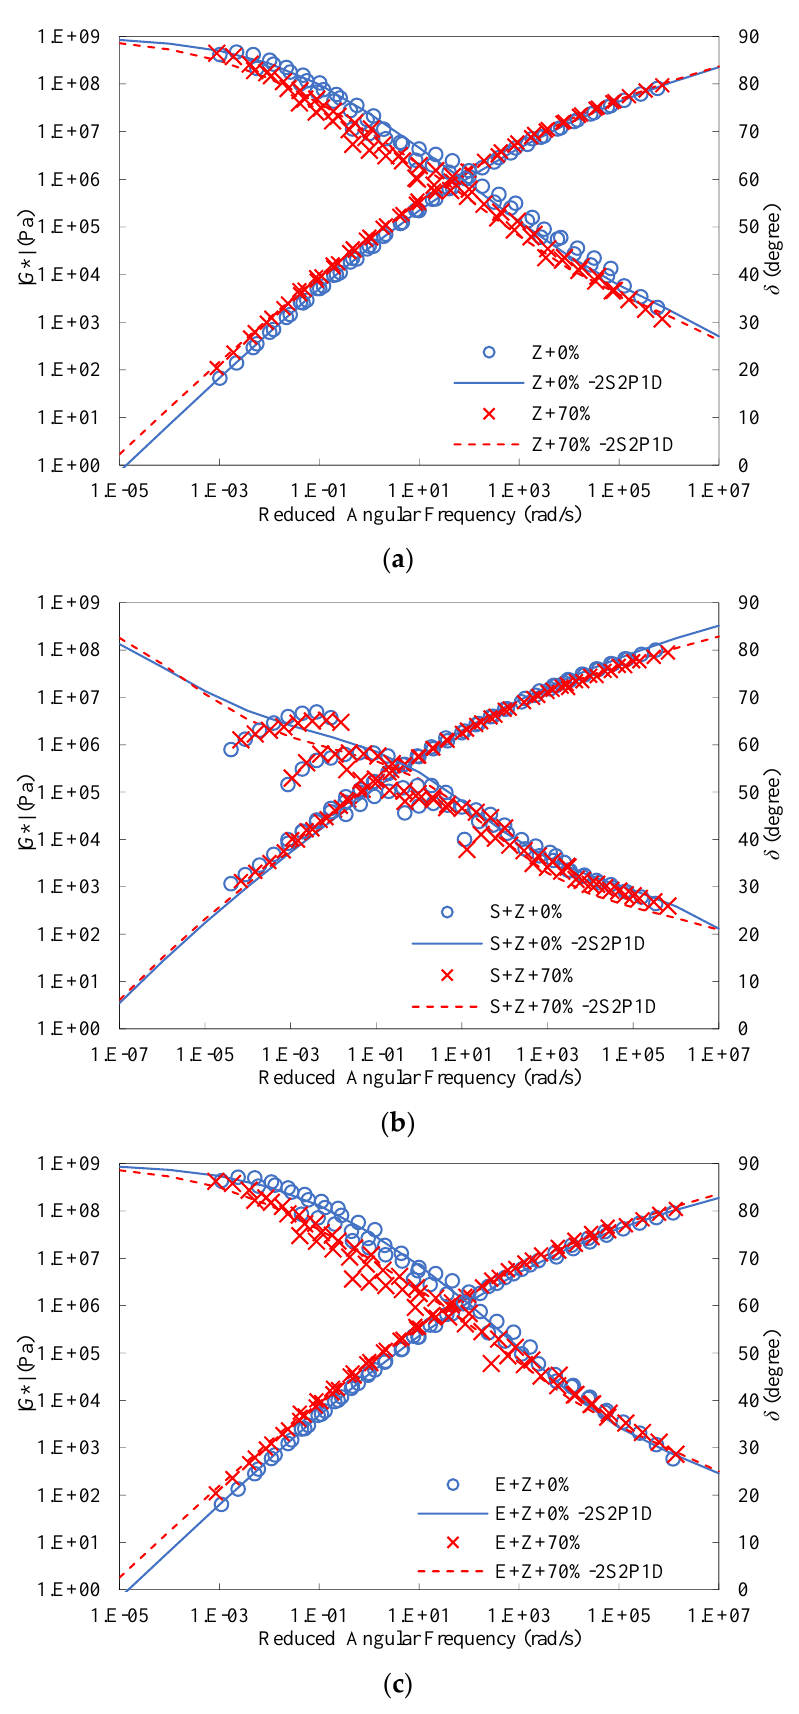
Figure 16. Calculated master curves of dynamic modulus and phase angle for: ( a ) Z binders; ( b ) S +